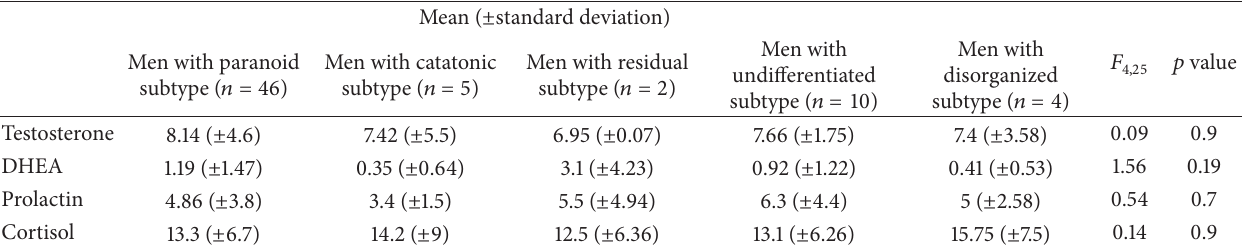
Table 5: Comparison using one-way analysis of variance of serum hormones levels in men with different subtypes of schizophrenia disorder.